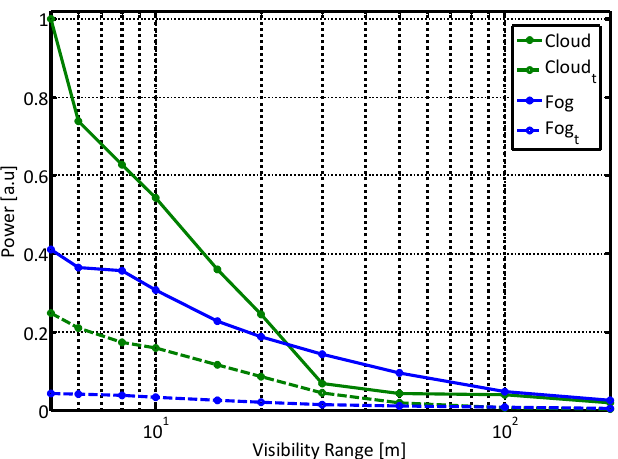
Figure 8. Normalized measured power, un-polarized and polarized (marked by the subscript t) signals. Aerosol chamber was filled with artificial fog and cloud.